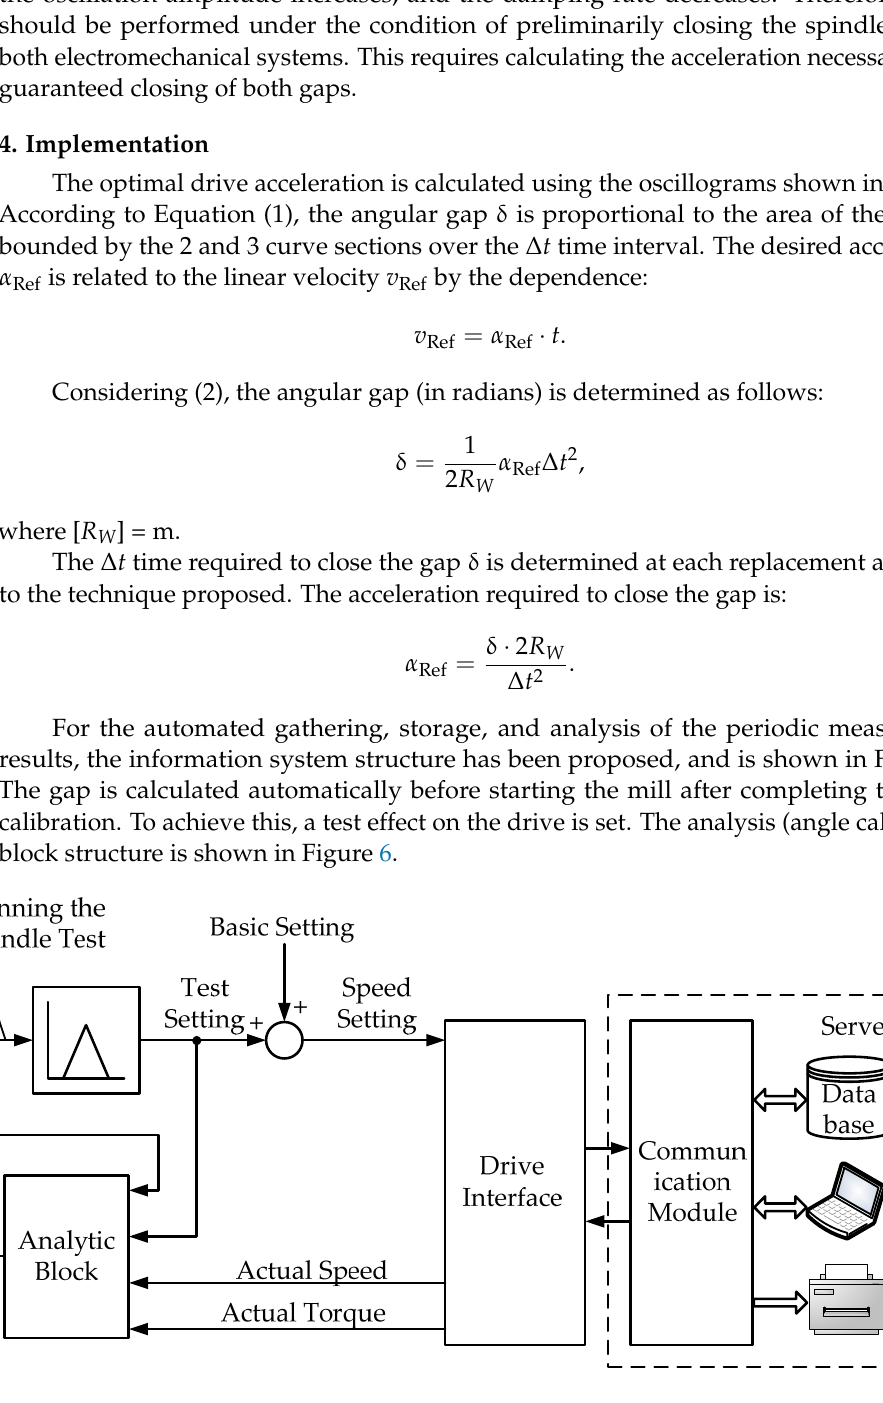
Figure 11. The spindle gap monitoring system structure.